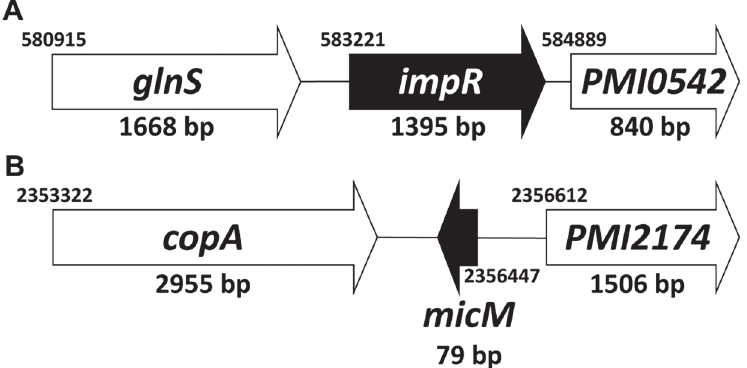
Fig 3. Genomic location of impR (A) and micM (B) in P. mirabilis . The number indicates the start nucleotide number of each gene in the genome and the size (bp) of each gene is